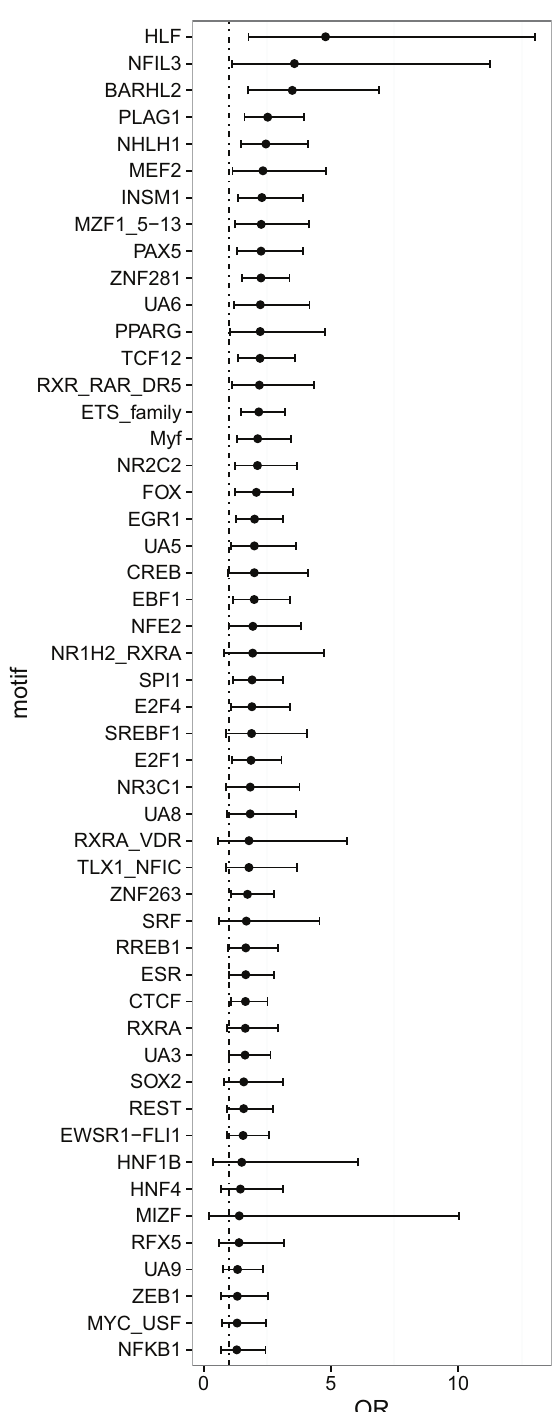
Figure 17. The plot shows the Odds Ratio (x axis) for the selected motifs. The range shows the 95% confidence